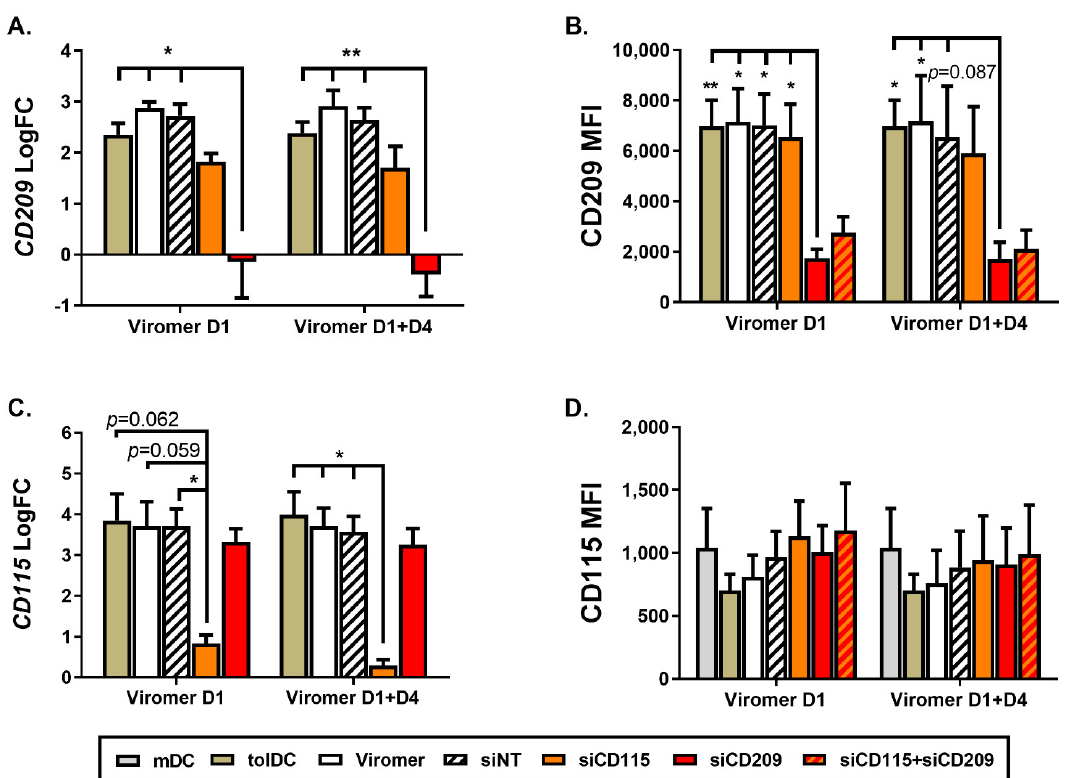
Figure 3. Down-modulation of CD115 and CD209 expression. Analysis of gene and protein expression of CD209 ( A , B ) and CD115 ( C , D ) by using specific siRNA + ViroB treatment of VitD3-tolDC on day 1 (D1) or on day 1 + day 4 (D1 + D4) of culture differentiation. Data shown as mean + SEM. n = 3 for all groups. Data of gene expression are referred to mDC and showed as logarithm in base 2 of fold change (FC). Graph B displays only statistical differences between siCD209 and the rest of the tolDC conditions. MFI: mean fluorescence intensity. * p < 0.05; ** p < 0.01.